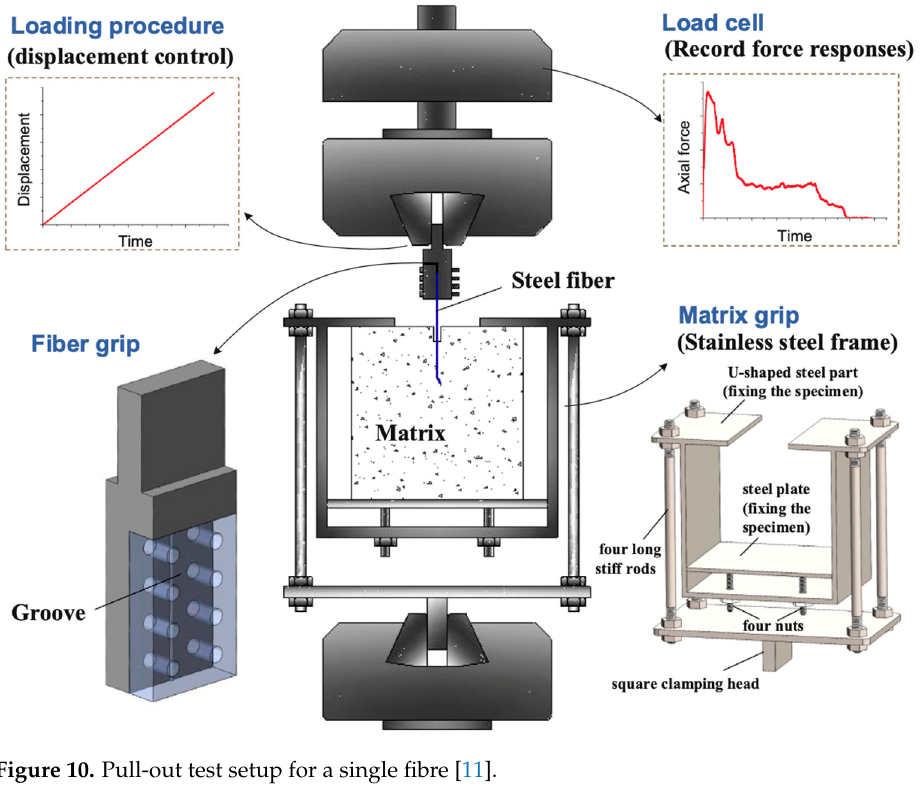
Figure 9. ( a ) Specimen casting in the moulds; ( b ) a–a cross-section; and ( c ) extracted pull-out speci- mens [11].